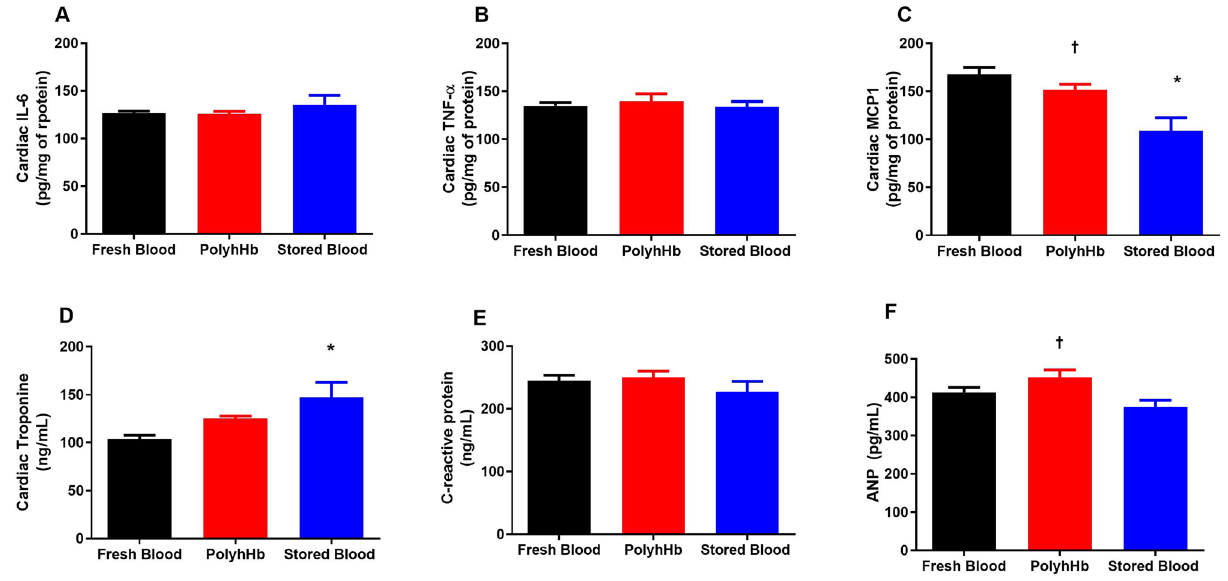
Figure 4. Markers of cardiac injury. Stored blood caused a greater degree of cardiac injury compared to fresh blood, since cardiac troponin increased for stored blood. However, resuscitation with stored blood or PolyhHb did not cause remarkable changes in cardiac inflammation. ( A ) Interleukin-6 (IL-6); ( B ) Tumor necrosis factor alpha (TNFα); ( C ) Monocyte chemoattractant protein-1 (MCP-1); ( D ) Troponin; (E) C-reactive protein; (F) Atrial natriuretic peptide (ANP). Measurements were taken 24 h after resuscitation. *, p < 0.05 vs. Fresh Blood; †, p < 0.05 versus Stored Blood. Statistical comparisons were completed using a one way—ANOVA; Tukey’s multiple comparison test.